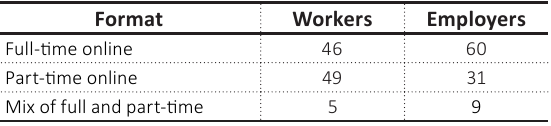
Table 4. Format of work during the lockdown, %